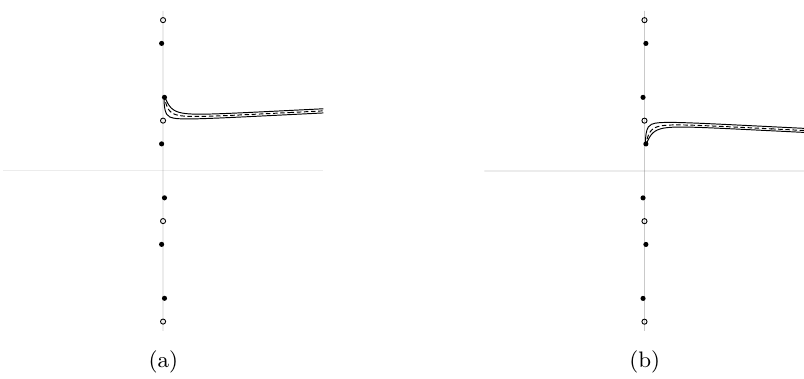
Figure 9. Reflected saddles ( Re( η ) > w ) . When η is real and greater than w , the only reflected solutions are singular. But one finds non-singular solutions for complex η . On the left η has a small positive phase and on the right it has a small negative phase. The contour is deflected in opposite directions by the pole in the two